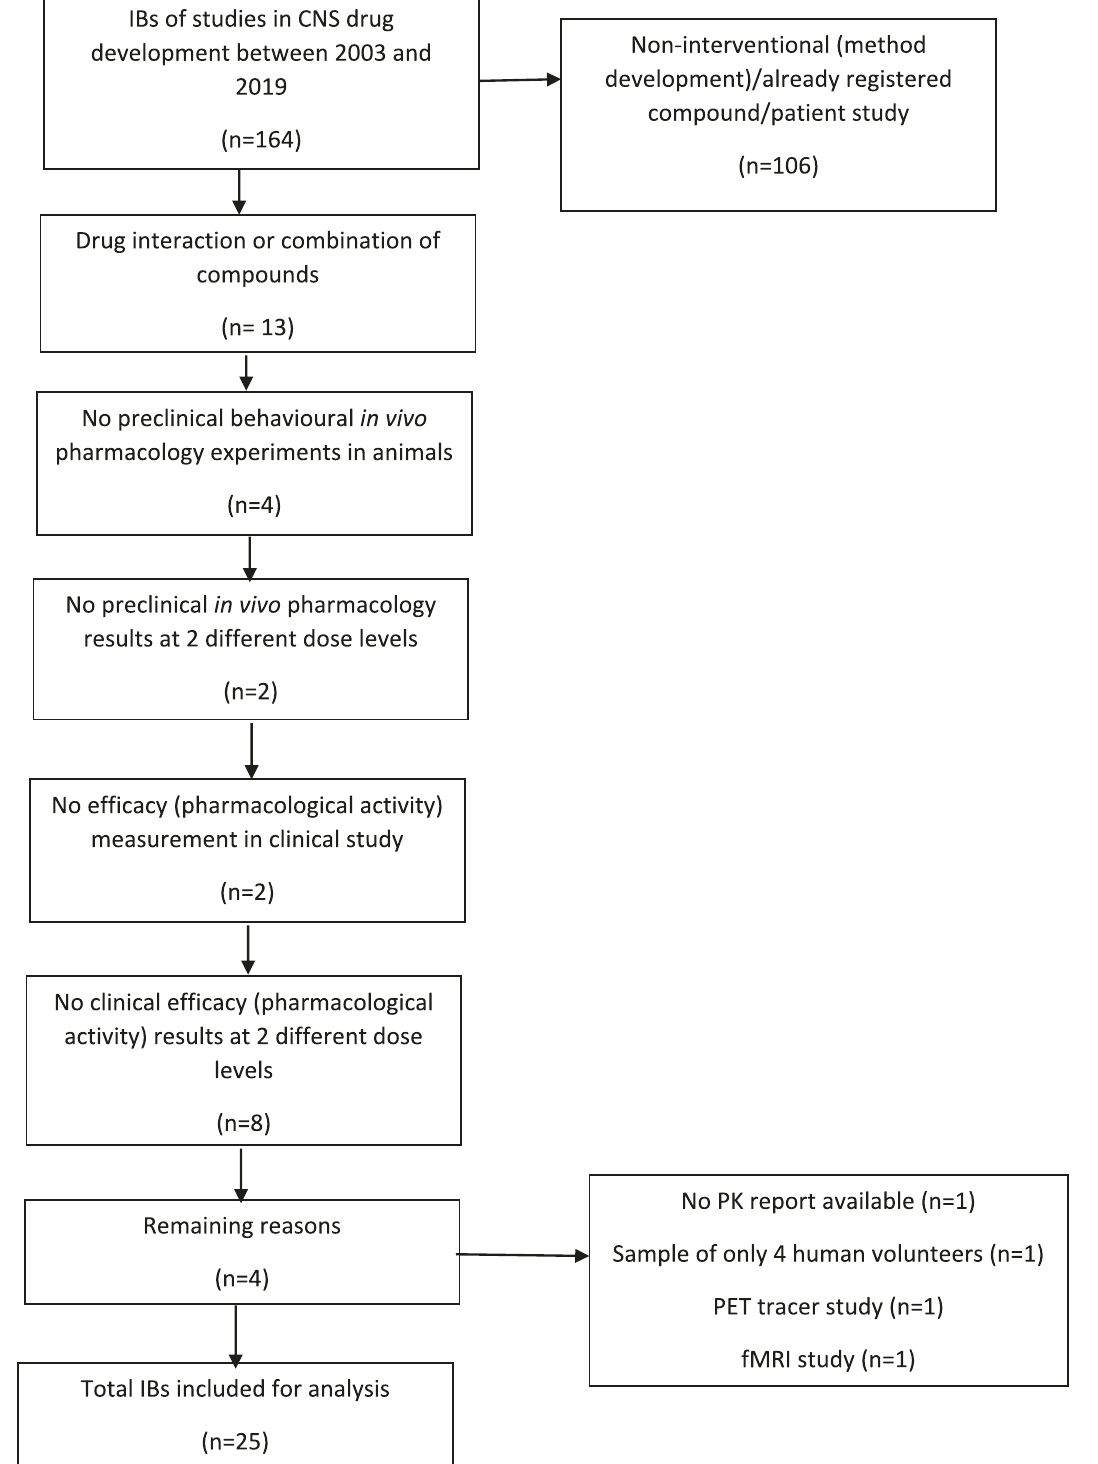
Fig. 2 Flowchart of included studies. It depicts the reasons of why studies were observed preclinically, but at much higher dose levels. Taken together, C max values seem to be the most accurate predictor of tolerability limits for CNS active compounds, with only 32% of clinical studies reporting well-tolerated doses above the NOAEL value, compared to 36% for HED and 52% for AUC. The percentage (16%) of clinical studies reporting unacceptable side